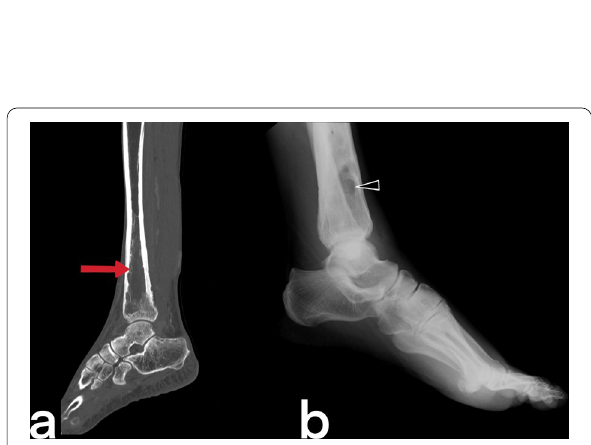
Treatment and follow‑up There are no medical treatment guidelines specific to EPTB. As in pulmonary TB treatment, EPTB is treated by 6–18 months of antitubercular chemotherapy. In tuberculous meningitis, corticosteroids are often used in addition to antitubercular chemotherapy, which can also help prevent fibrotic sequelae, including constric- tive pericarditis and stenosis that may develop in hol- low internal organs such as the intestine and ureter [7, 58].